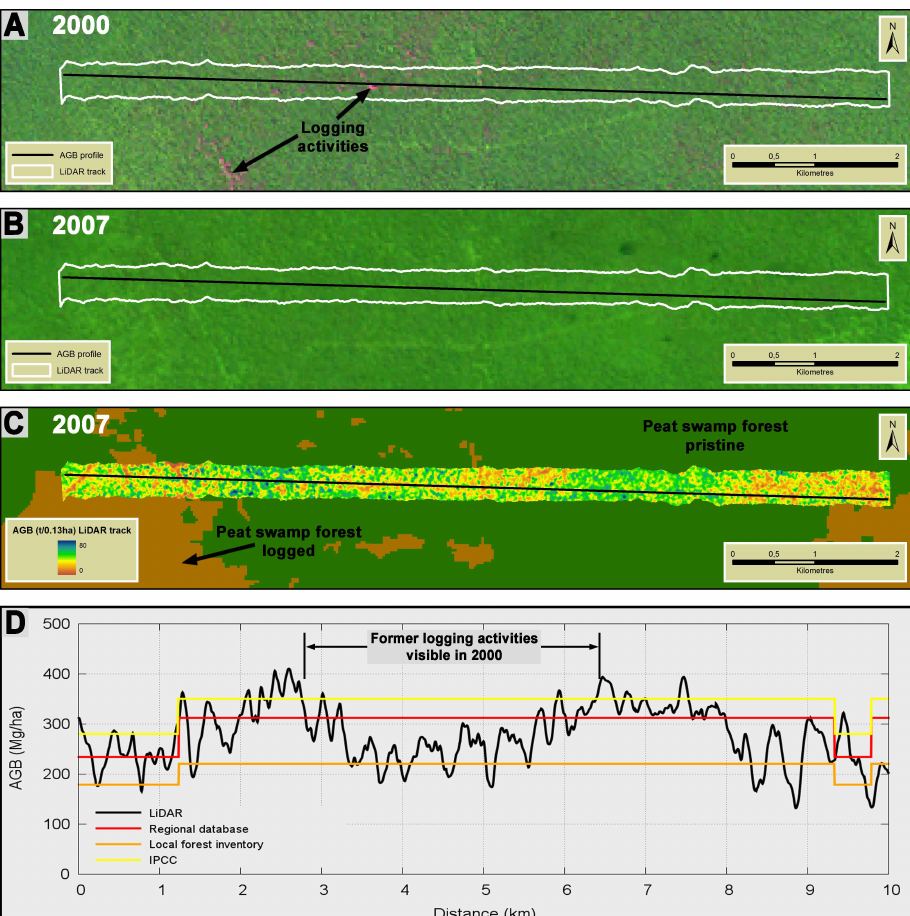
Fig. 5. AGB results shown for a LiDAR track covering 10km in the Sebangau peat swamp forest catchment. Location of this LiDAR track is shown in Fig. 6 (AGB profile 1). (A) Extent of the LiDAR track and the location of the AGB profile of (D) superimposed on a Landsat scene from the year 2000 (ETM + 118-62, 2000-07-16; bands 5-4-3). Green represents forest cover, and logging activities are visible as pink dots near straight line features (logging railways). (B) Extent of the LiDAR track and the location of the AGB profile of (D) superimposed on a Landsat scene from the year 2007 (ETM + 118-62, 2007-08-05; bands 5-4-3; gap filled). The logging activities are not visible anymore. (C) LiDAR AGB regression results superimposed on the Landsat classification (green = peat swamp forest pristine; brown = peat swamp forest logged). (D) AGB variability measured by LiDAR (black) and the corresponding AGB estimates attributed to the land cover types of the Landsat classification. Site-specific inventory data (field plots) = orange; regional literature estimates (regional database) = red; and IPCC default values (IPCC) = yellow. Black arrows indicate the extent of the logging activities seen in (A)